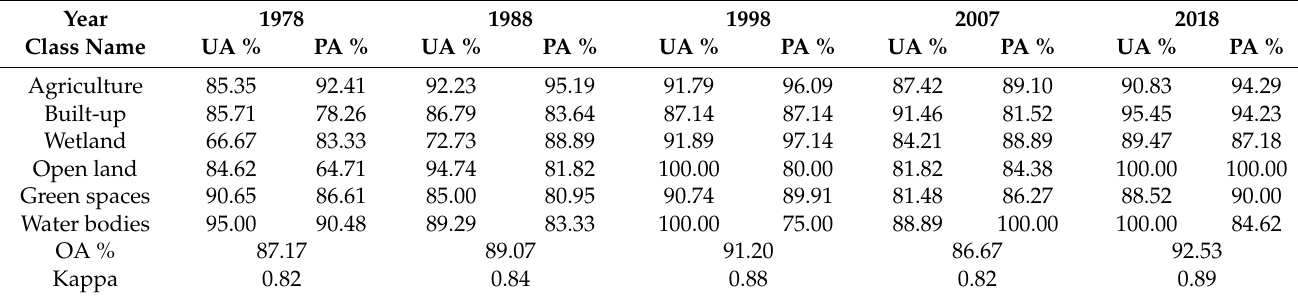
Table 4. Accuracy